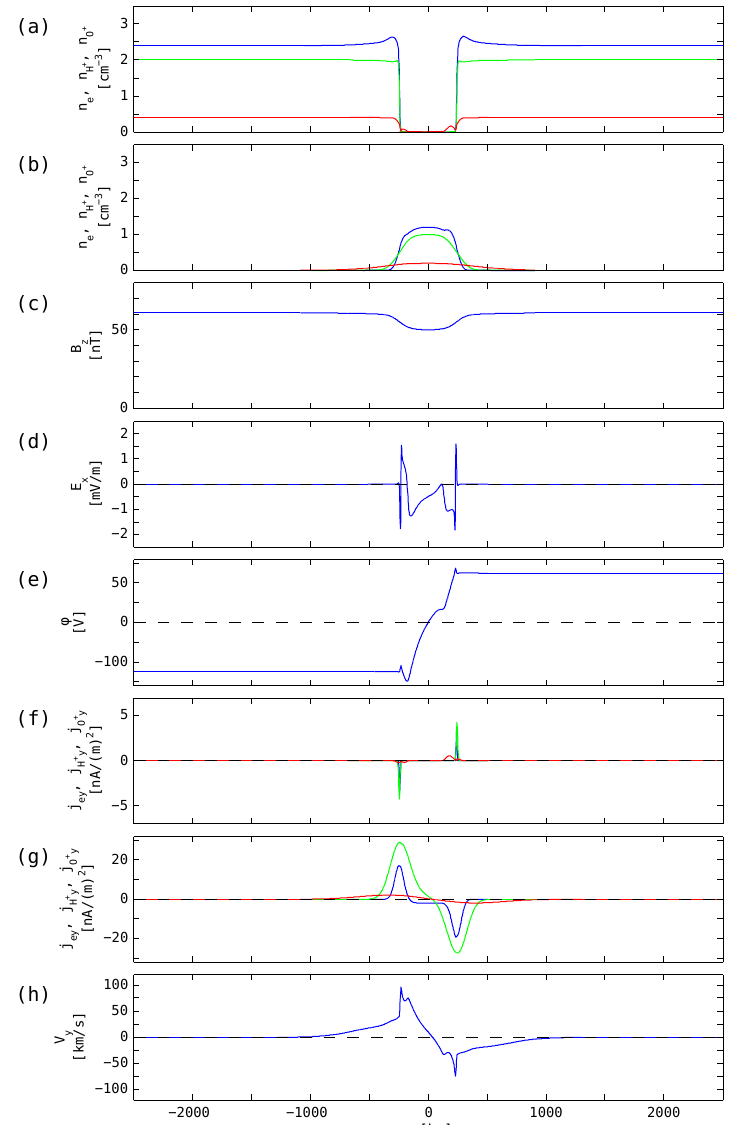
Fig. 9. Plasma and field structure of a 500km-wide e − -H + -O + plasma slab embedded in a uniform background. The plasma parameters are given in Table 1, except for the values of p ( l ) and p ( r ) that have been reduced by a factor of 4. There is a cross-field flow V 0 y = 10kms − 1 0 0 at the slab centre. The electric potential boundary conditions are φ( ±∞ ) = ± 125V. The figure format is the same as in Fig. 4.